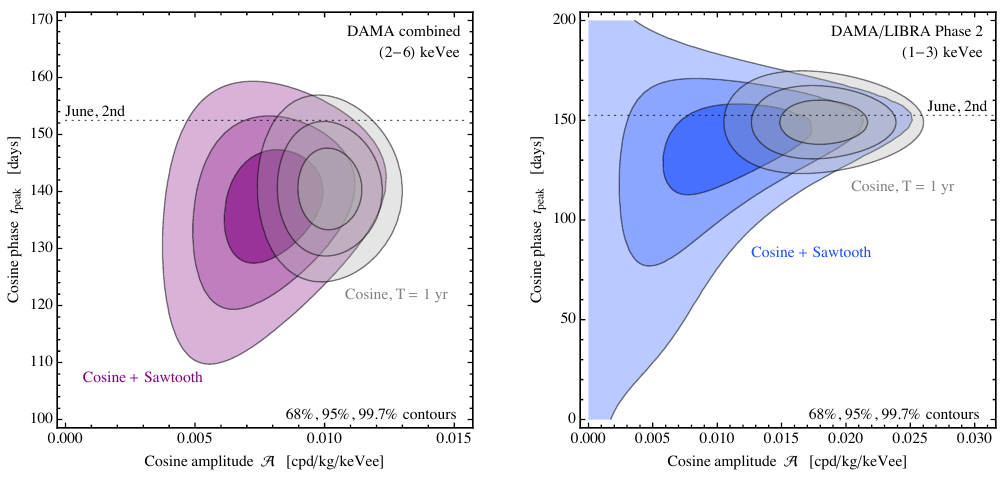
Figure 7 . Left: (cid:12)t of the cosine amplitude and its phase to DAMA residuals, allowing for a sawtooth component (colored regions) or setting it to zero (gray regions). Left: combined (cid:12)t in the (2{ 6) keVee energy window. Right: (cid:12)t of DAMA/LIBRA Phase 2 residuals in the (1{ 3) keVee energy